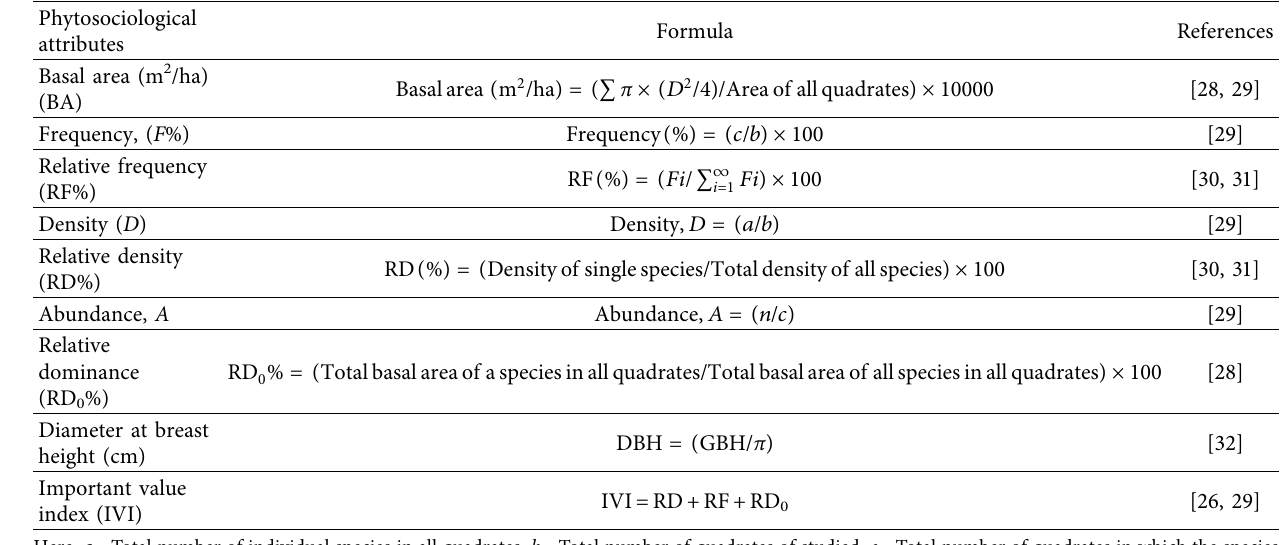
Table 2: The list of equations used for calculating phytosociological characters of the vegetation.